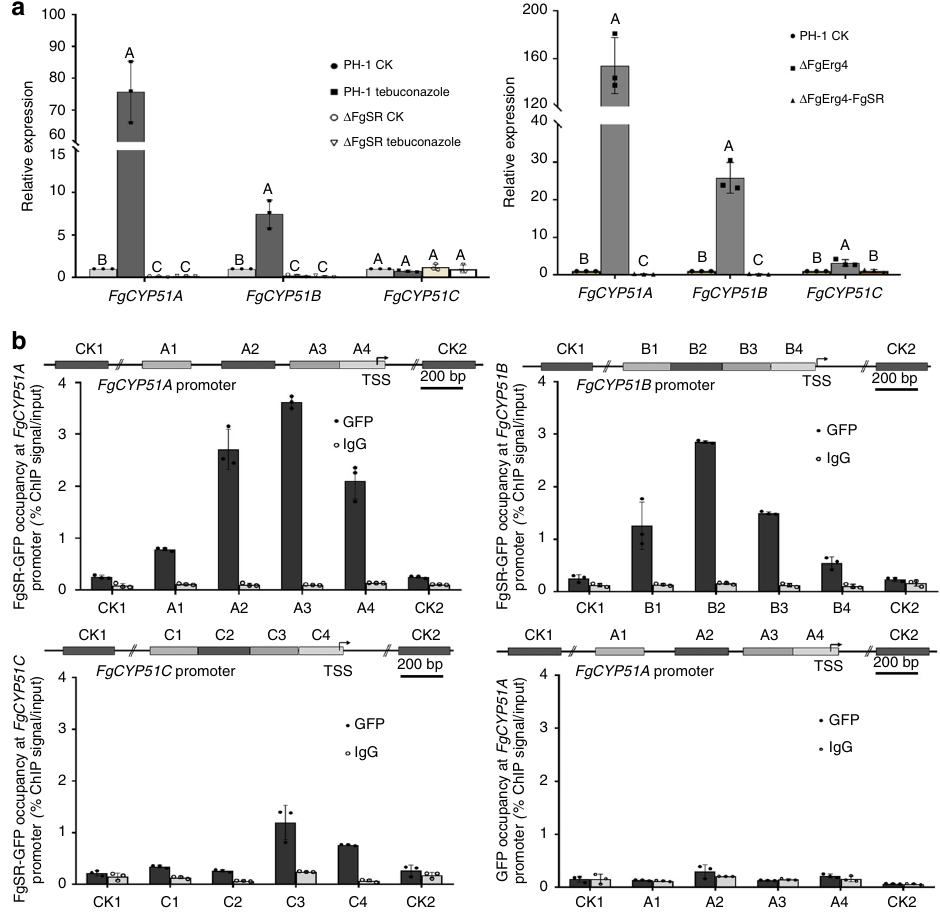
Fig. 2 FgSR enriches at the promoters of three FgCYP51 genes and regulates their transcription in F. graminearum . a The transcription of FgCYP51A and FgCYP51B was regulated by FgSR, whereas, expression of FgCYP51C was modulated by FgSR only under the ergosterol-absent condition. Each strain was cultured in YEPD for 36 h, and then treated with 2.5 μ g ml – 1 tebuconazole for 6 h (left panel). Δ FgErg4 was used to mimic the ergosterol-absent condition (right panel). The expression level of each FgCYP51 in PH-1 without treatment was referred to 1 and the FgACTIN gene was used as the internal control for normalization. Data presented are the mean ± s.d. ( n = 3). Bars followed by the same letter are not signi fi cantly different according to a LSD test at P = 0.01. b FgSR binds to the promoters of three FgCYP51 genes, but the enrichment of FgSR at FgCYP51A and FgCYP51B is more than that at FgCYP51C . Each strain was incubated in YEPD liquid medium for 36 h. ChIP- and input-DNA samples were quanti fi ed by quantitative PCR assays with primers amplifying different regions indicated on the diagram of each FgCYP51 promoter. A control reaction was processed in parallel with rabbit IgG and PH-1 transformed only with GFP used as a negative